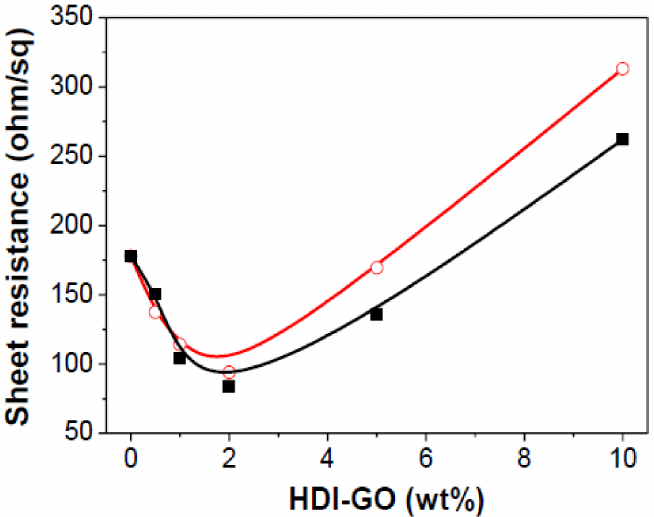
Figure 6. Sheet resistance of PEDOT:PSS nanocomposites reinforced with HDI-GO 6 ( open circles ) and HDI-GO 1 ( solid squares ) as a function of the HDI-GO